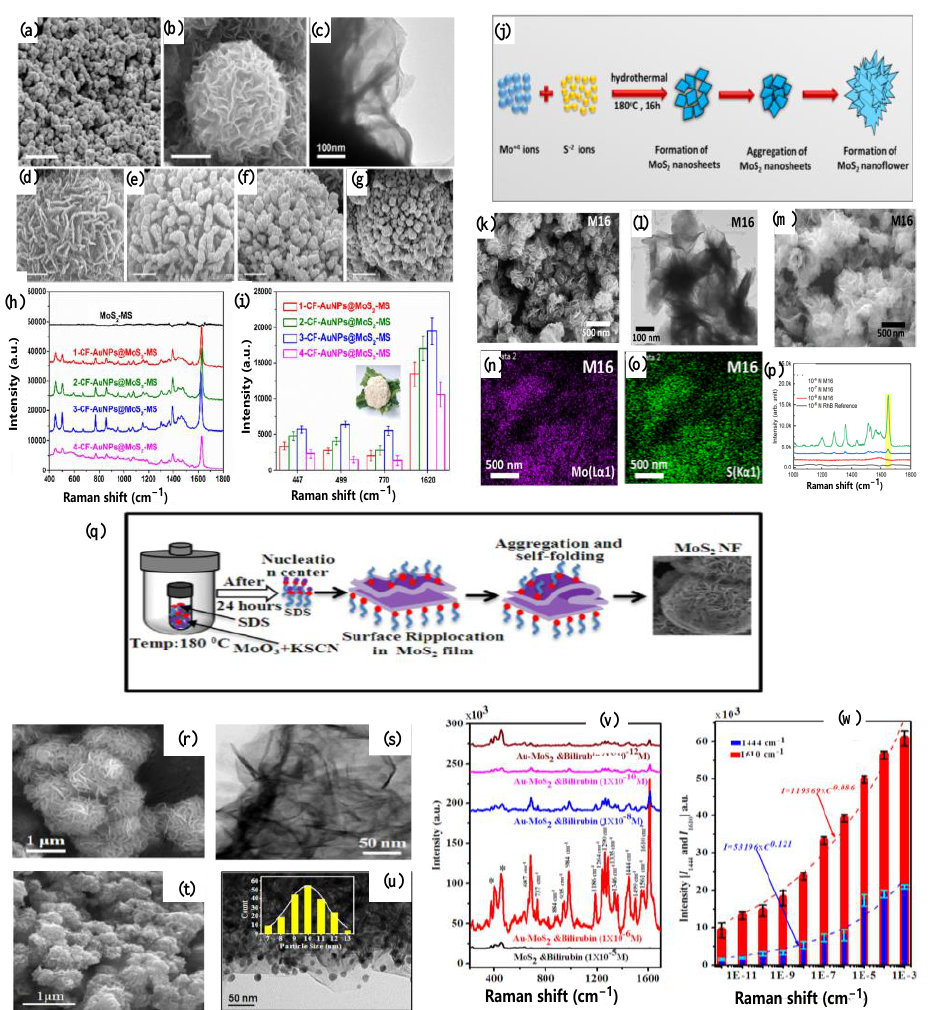
Figure 10. ( a , b ) FESEM image of hierarchical MoS 2 microspheres (MoS 2 -MS) in low magnification. ( c ) TEM image of hierarchical MoS 2 microspheres. ( d – g ) SEM images of the AuNPs modified micro- spheres (Au NPs@MoS 2 -MS) with different HAuCl 4 concentrations, respectively were ( d ) 1 mM, ( e ) 2 mM, ( f ) 3 mM, and ( g ) 4 mM. Scale bar: 200 nm. ( h , i ) SERS activity of the pure MoS 2 -MS, 1-, 2-, 3-